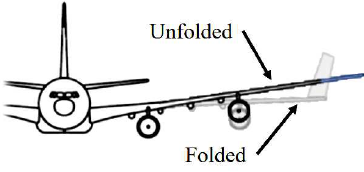
Figure 6. Wing shape adaptation due to flexibility and wingtip